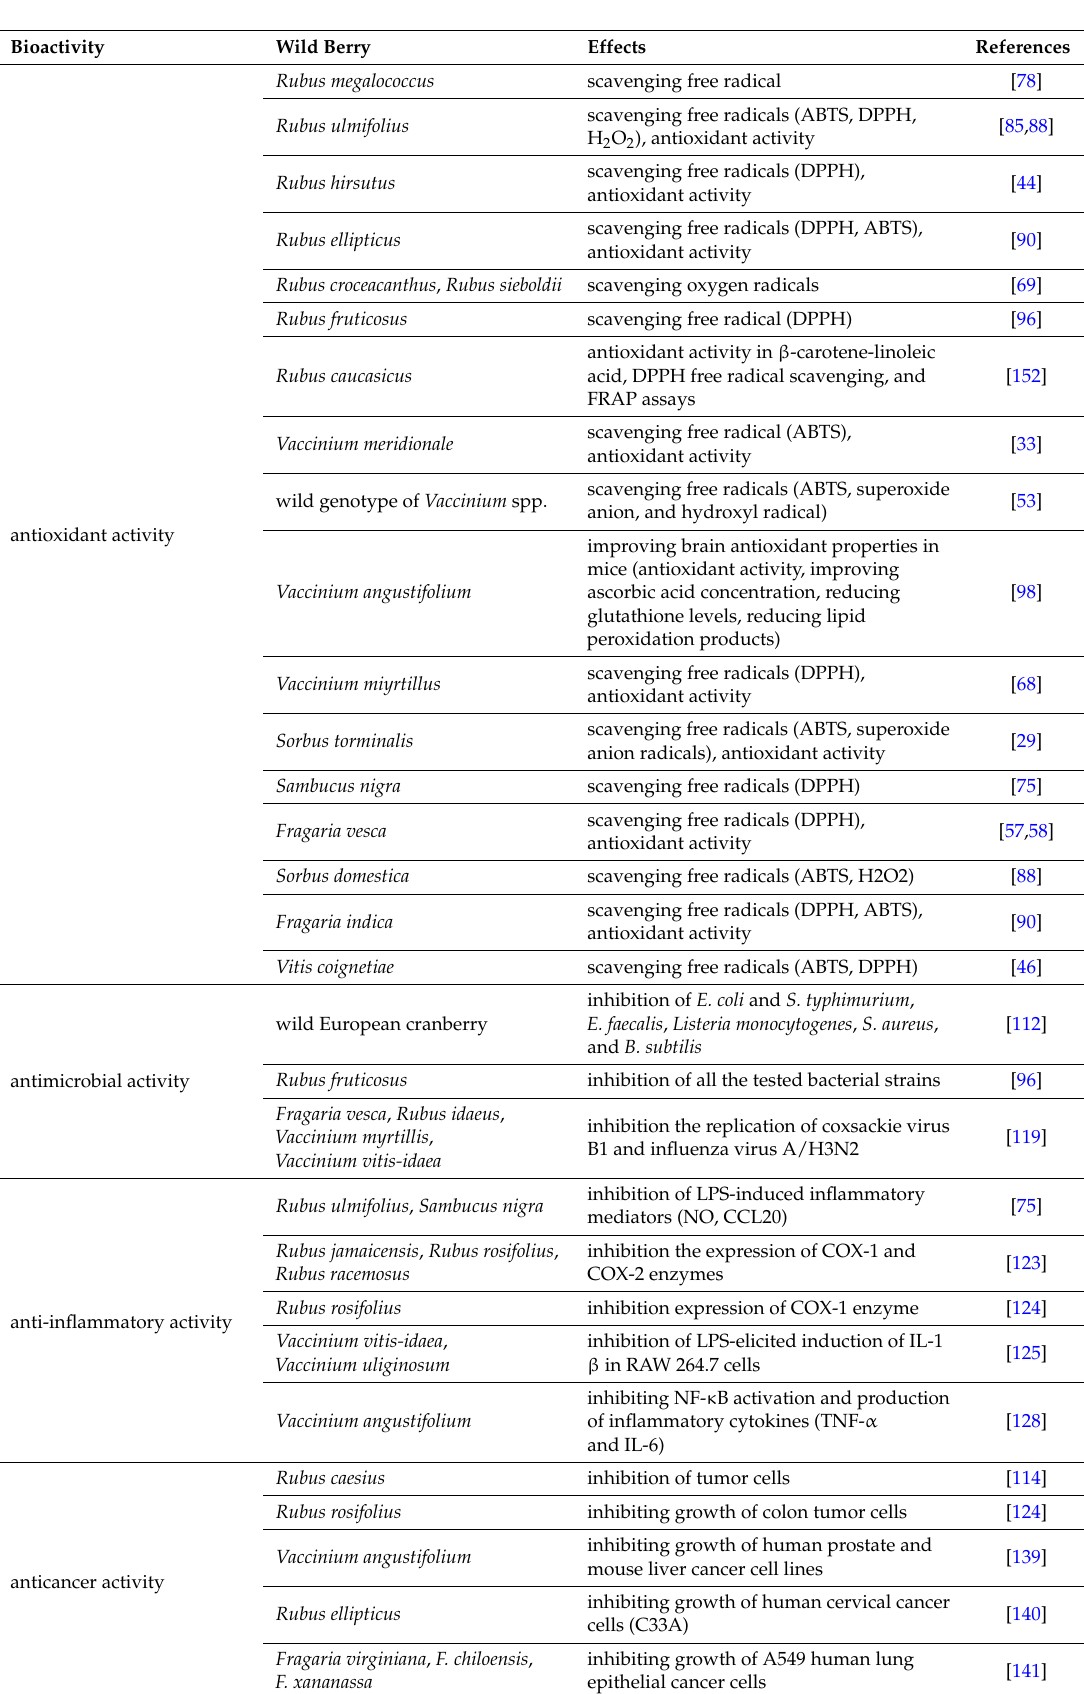
Table 6. Bioactivities of some wild